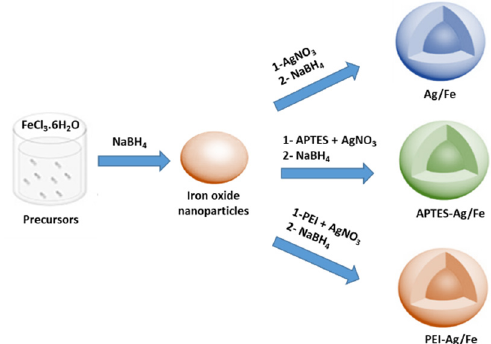
Figure 1. Illustrated scheme for the preparation of catalysts Ag / Fe, 3-amino propyltriethoxysilane (APTES)-Ag / Fe, and poly(ethyleneimine) (PEI)–Ag / Fe by a two-step reduction process .